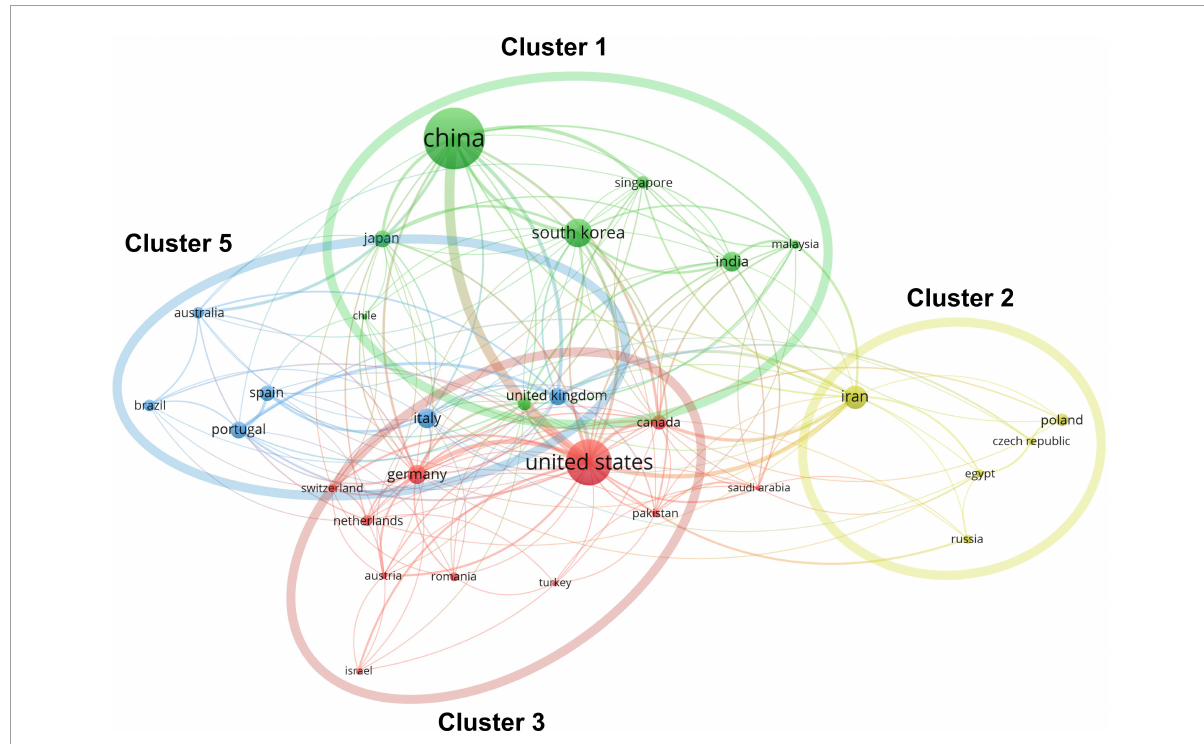
FIGURE2 Co-authorship analysis of countries/regions divided into five clusters indicated with different colors. The large icon indicates countries/regions with high frequencies. Maximum number of countries per paper: 25; minimum number of countries per paper: 10; and minimum number of citations from one country: